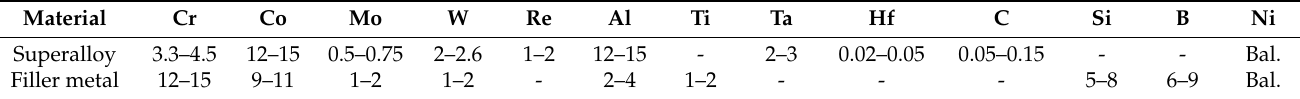
Table 1. The chemical composition of the base material and filler (at.%).